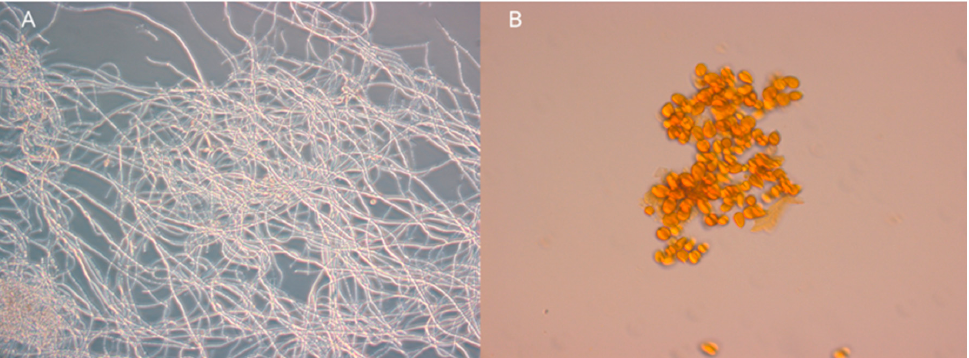
Figure 6. Biological activity test against spore germination of Botrytis cinera after 10 days incubation at 25 ° C on YPD broth ( A ) and YPD broth containing purified antifungal compound ( B ). Images show light microscopy photographs (× 400) of fully germinated mycelia ( A ) and non-germinated spores ( B ). Table 2. Antimicrobial activity using disk diffusion assays against epipyrone A disalt.